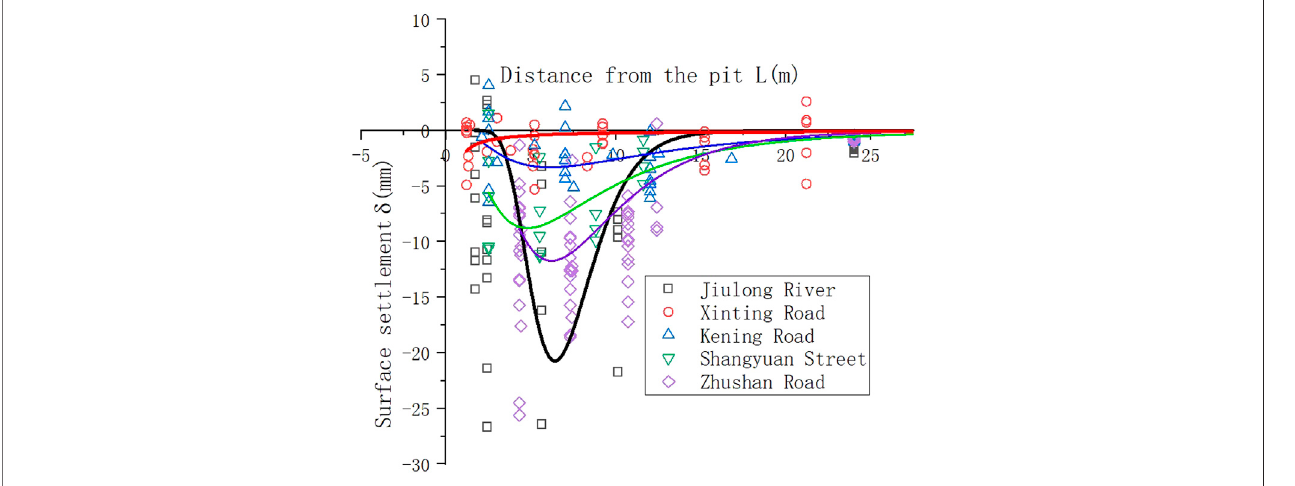
FIGURE 8 | Typical settlement trend of stations of Nanjing Metro Line 5.